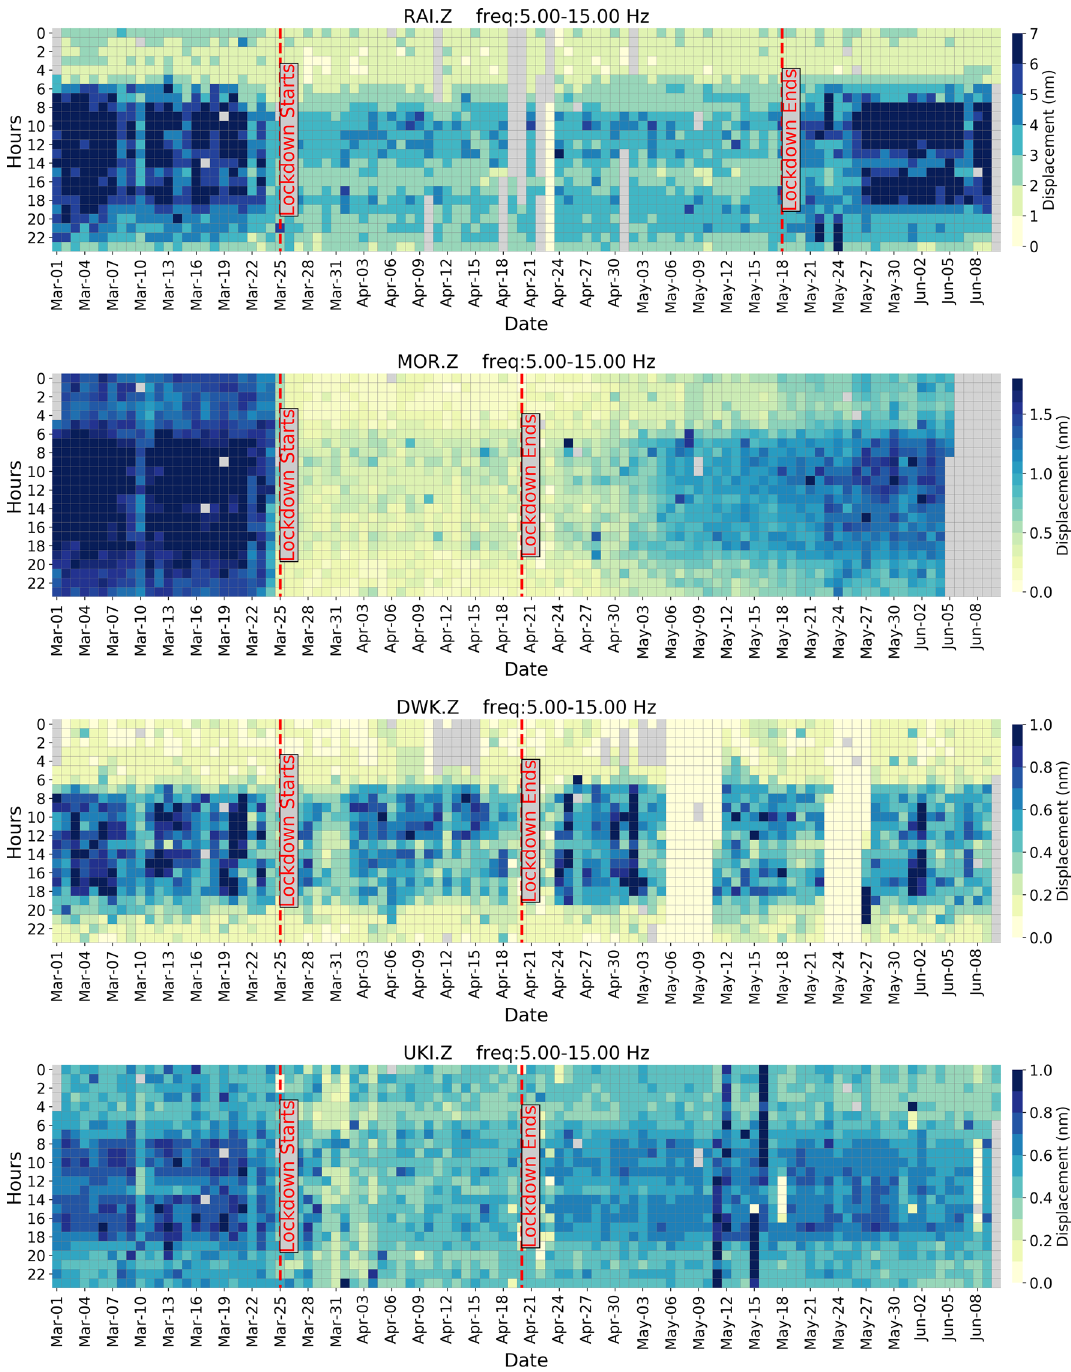
Figure 7. Day wise hourly variation in ground displacement (d rms , in nm) during pre-, co- and post- lockdown periods at RAI, MOR, DWK and UKI stations in the frequency range of 5–15 Hz. Here, the data are normalized to the 15–85th percentiles of the pre-lockdown period for better representation and comparison purpose. Gray colour represents the data gap. Time is mentioned in IST. Subsurface geology and other local anthropogenic conditions are mentioned in Table 1. Plots for other stations are shown in supplementary Figure located in the vicinity of ceramic factories, due to the closure of all kinds of activities (Fig. 5; Table 1). Both during the day (79%) and nighttime (87%), we observed a sharp reduction in noise levels, since these factories work round the clock. Since machineries in these ceramic factories are operated throughout the year on all days round the clock, a large drop in d rms values is noticed for all days of the week during the pre- and co-lockdown periods, for station MOR (Fig. 6). Further, during the pre-lockdown period, the noise levels peak during 7–9 h